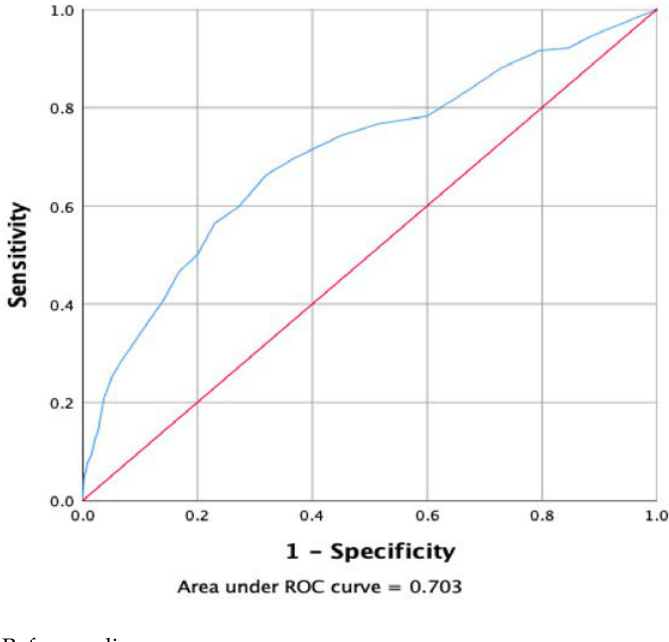
Figure 4. The receiver operator curve (POC) of the C-FCV-19S based on positive-anxiety. Furthermore, participants were divided into the without and with fear COVID-19 groups according to the cutoff point of 17.5. As shown in Table 5, compared to the without fear of COVID-19 group, the group with of fear COVID-19 had significantly higher HAMA scores (2.51 ± 3.38 vs. 4.80 ± 4.56, p < 0.001), HAMD scores (3.98 ± 4.17 vs. 6.56 ± 5.45, p < 0.001), and higher rates of anxiety and depression (all p < 0.001) symptoms. Further binary logistic regression was used to predict anxiety (B = 0.119, df = 1, OR = 1.126; 95%CI: 1.102–1.151; p < 0.001) and depression symptoms (B = 0.110, df = 1, OR = 1.116; 95%CI: 1.097–1.135; p < 0.001). Table 5. comparison of with and without fear COVID-19 in anxiety and depression.